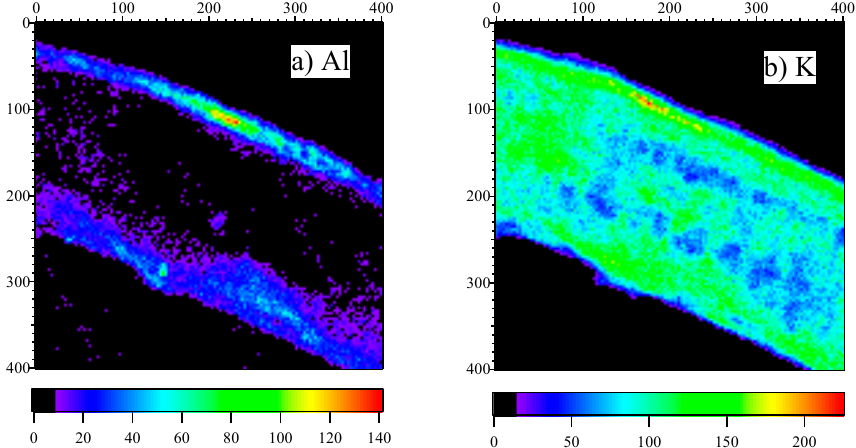
Figure 3. Elemental distributions of ( a ) Al and ( b ) K in the whole leaf. Al was located in both epidermises, while potassium was distributed all over the leaf showing some